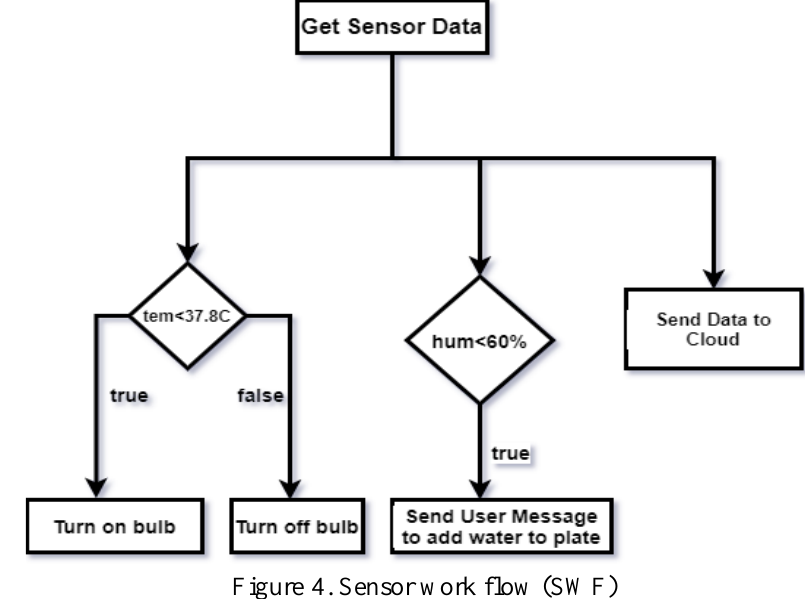
Figure 4. Sensor work flow